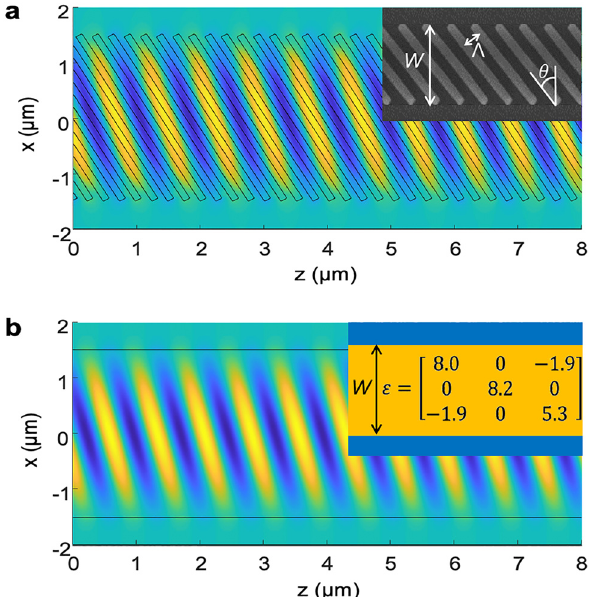
Figure 1: Simulated propagation of the electric field through (a) a tilted subwavelength waveguide and (b) the equivalent homogeneous anisotropic waveguide. Linear polarization in the x – z plane and a free-space wavelength of 1.55 μ m are considered. In both (a) and (b), the geometry of the waveguide is outlined in black. The waveguide layer is 220 nm thick and 3 μ m wide. In (a), Λ = 250 nm, DC = 0.5 and θ = 30 ° . In (b) the permittivity tensor of the waveguide core metamaterial is